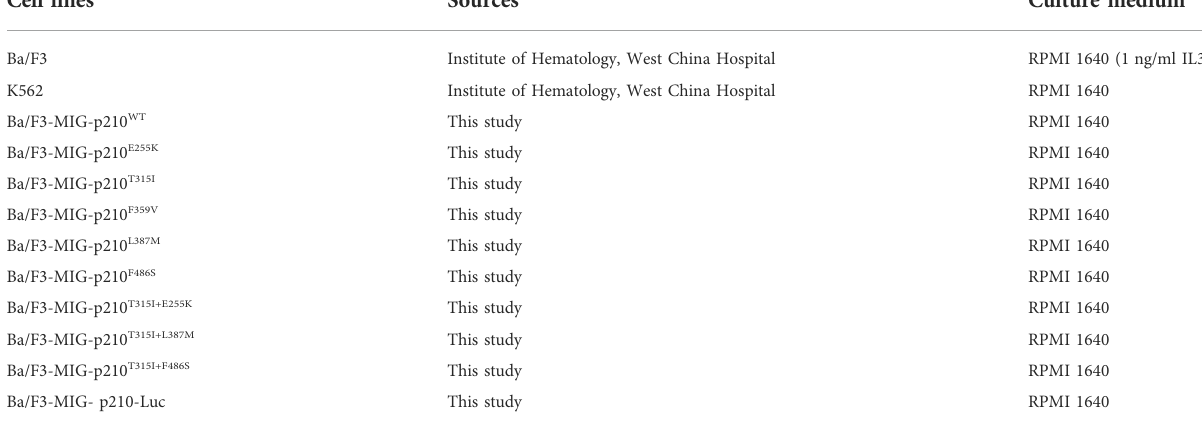
TABLE 1 The source of cell lines and the required culture